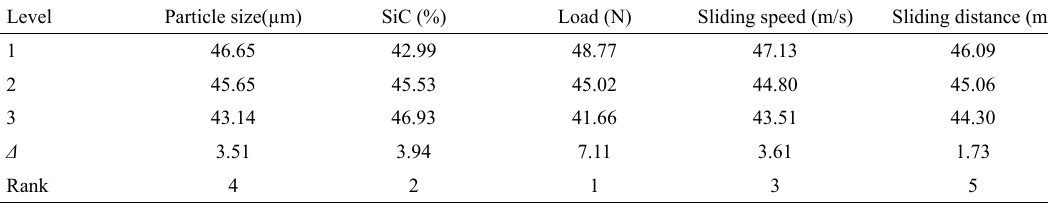
orthogonal array and results for Al5059/SiC/MoS Table 4. L 27 Particle Sl.No size (µm)